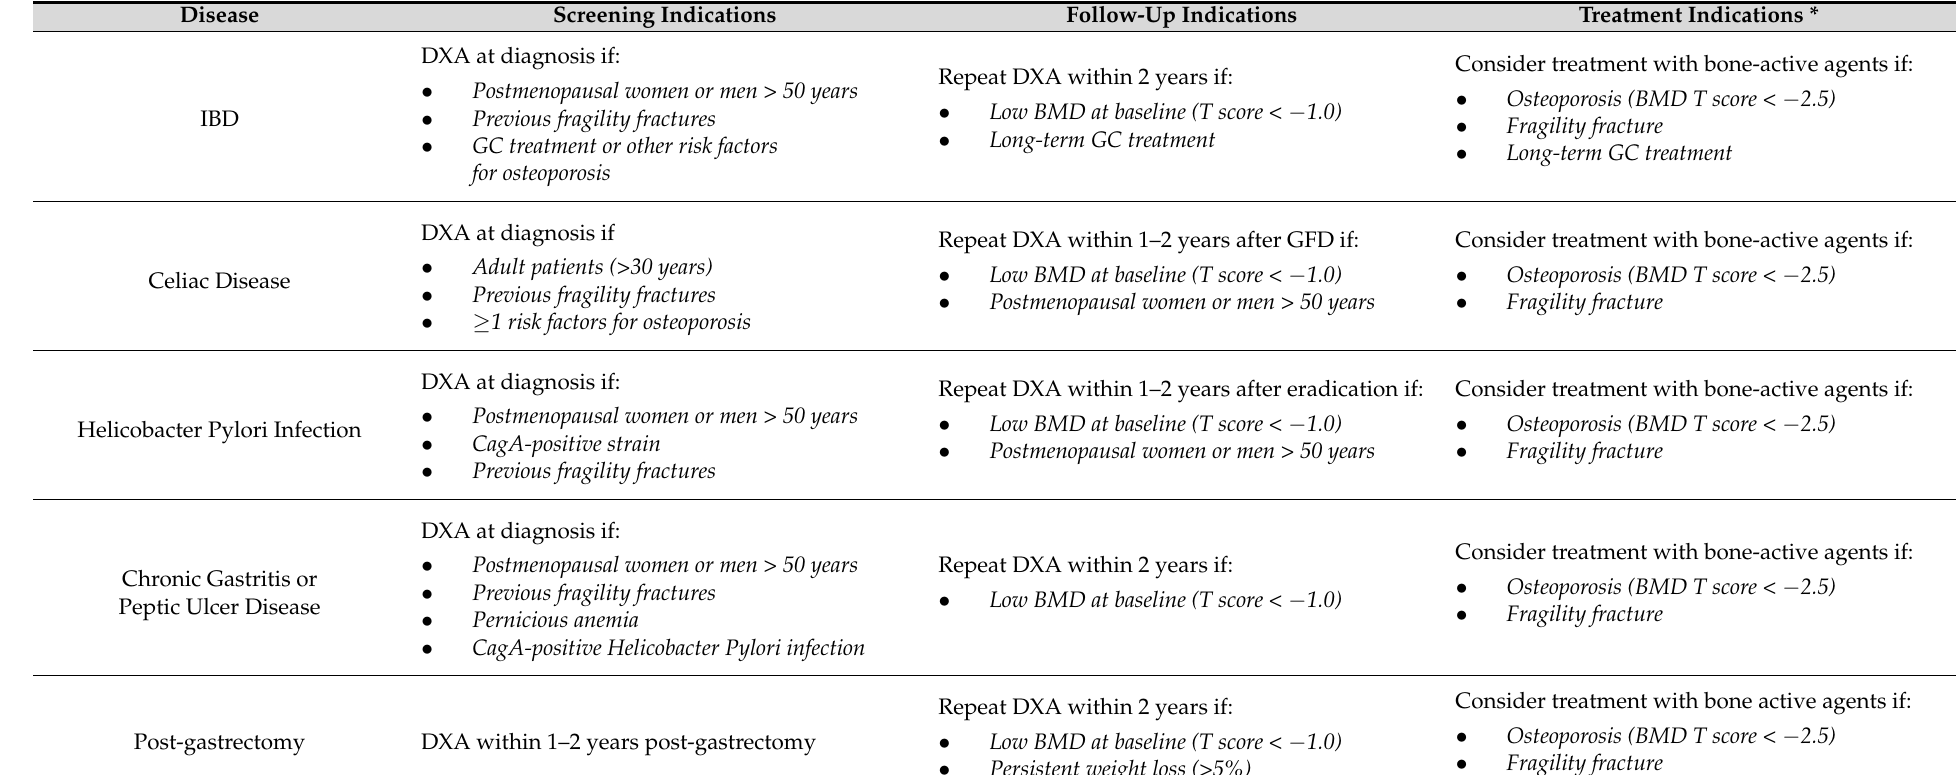
Table 2. Suggested diagnostic and therapeutic indications for the management of bone health in patients with major gastrointestinal disorders.